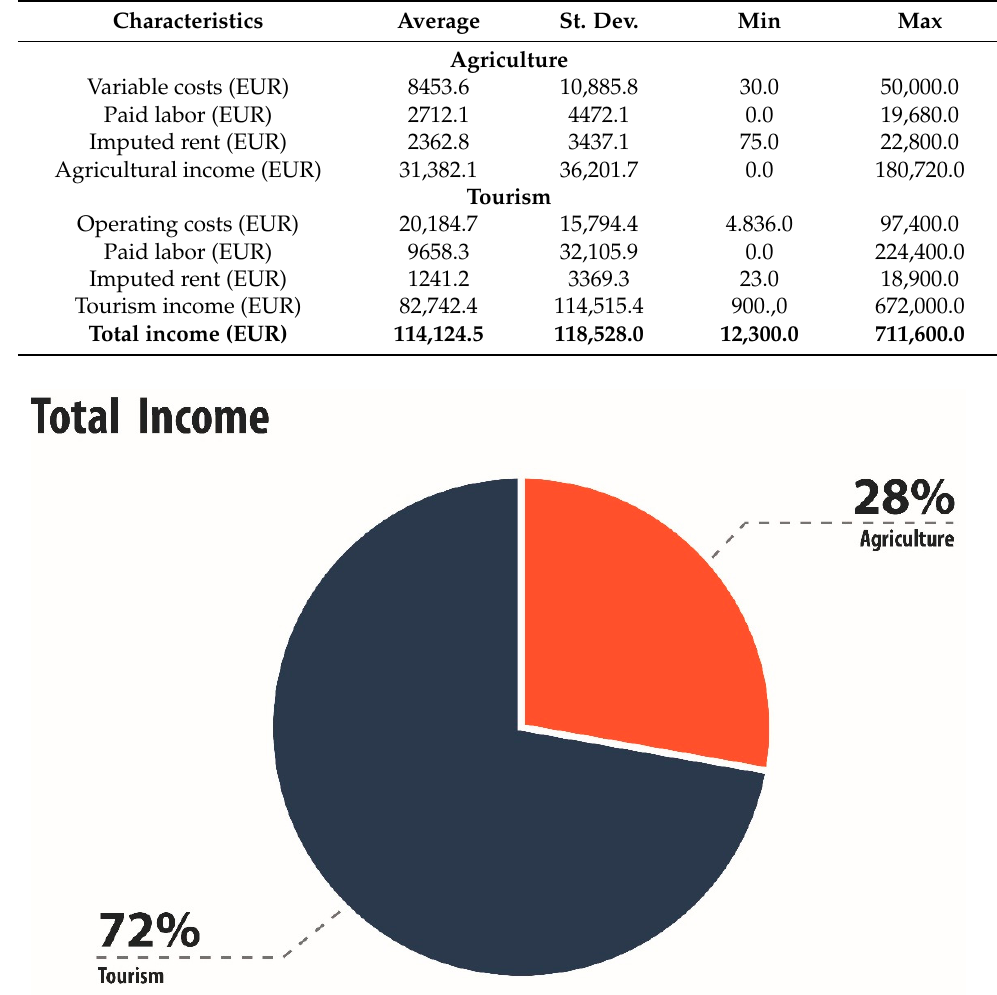
Figure 3. Share in total income (in percentages).